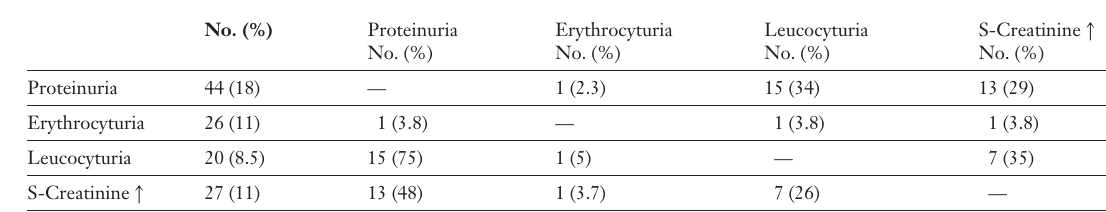
The table indicates absolute numbers and percentages (in parentheses) of patients with (a) given finding(s). The numbers in the first column relate to the findings listed vertically (percentages relative to entire study population). The remaining columns indicate numbers of patients with combined findings listed in the respective column and line (percentages relative to number in the first column). S-creatinine ↑ indicates an increase in serum creatinine. All parameters were determined at the time of hospitalisation before death.